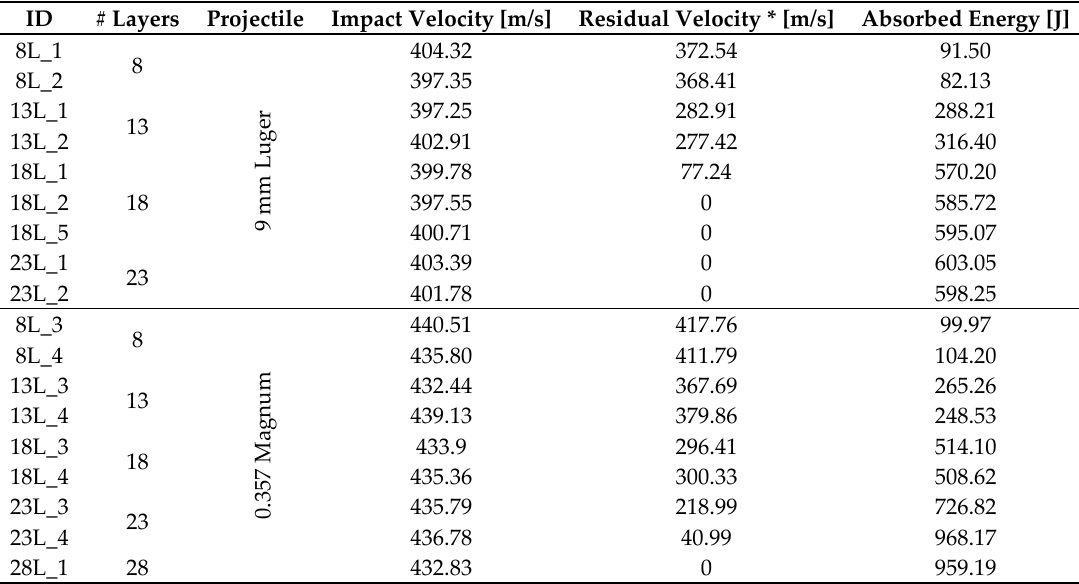
Table 1. Specimens subjected to ballistic